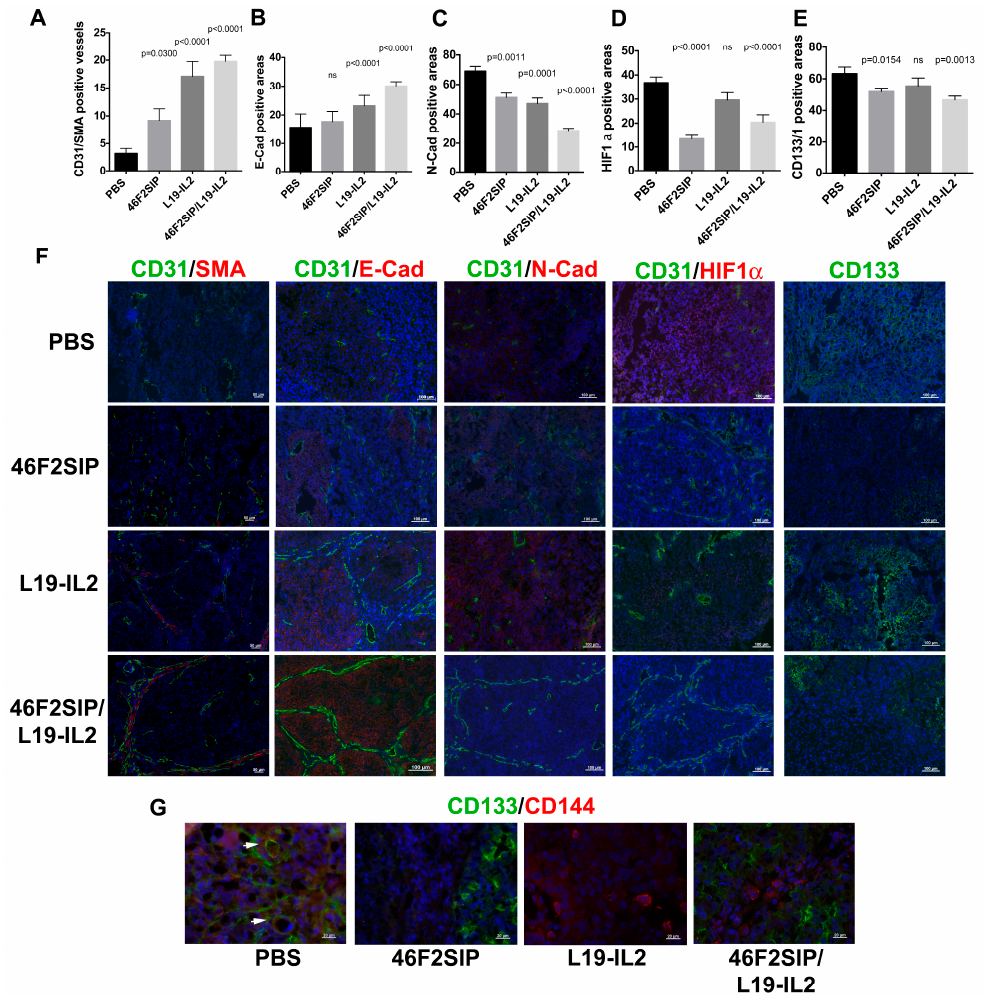
Figure 6. Effects of 46F2SIP/L19IL2 combined therapy on treated tumors. Quantification of CD31/SMA double positive vessels ( A ), E-cadherin ( B ), N-cadherin ( C ) HIF1 alpha ( D ), and CD133/1 ( E ) positive areas from the tumor sections of treated mice, stained as shown ( F ) using ImageJ software. (F) Immunofluorescence analysis of cryostat sections of tumors recovered from SKOV3/NOD SCID mice subjected to the different types of treatment, stained as indicated in each picture and counterstained with DAPI. ( G ) Immunofluorescence analysis of cryostat sections of tumors recovered from SKOV3/NOD SCID mice subjected to the different types of treatments for the expression of cancer stem cell marker CD133/1 and VM marker CD144. Nuclei were counterstained with DAPI. Statistically different p values between the groups connected by lines are also reported. Note: ns = no significantly differences between the indicated groups. Scale bars, 20, 50 or 100 m.